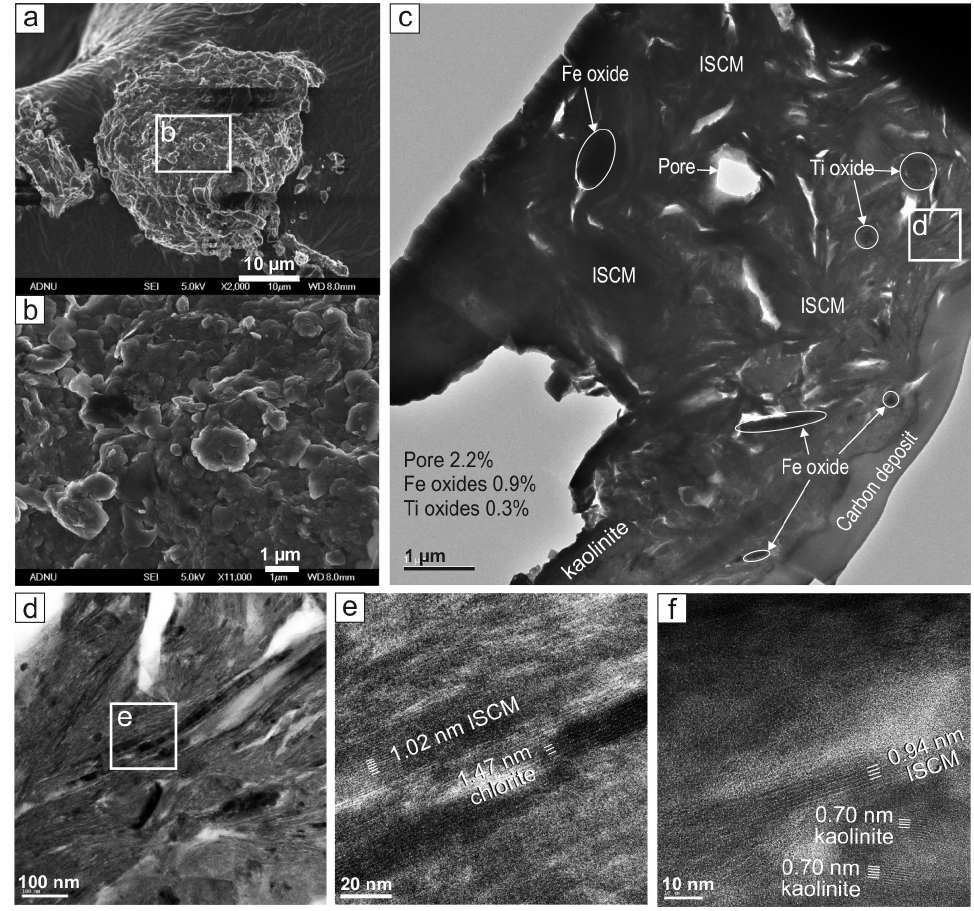
Figure 2. Clay-rich dust particle #1 from 2012 Asian dust. (a) SEM image of the dust particle. (b) SEM image of the particle surface magnified from the box in (a) . (c) Overall TEM image of FIB slice prepared from the particle in (a) . (d) TEM image magnified from the box in (c) . (e) TEM lattice fringe image of ISCM and chlorite. (f) TEM lattice fringe image of ISCM and